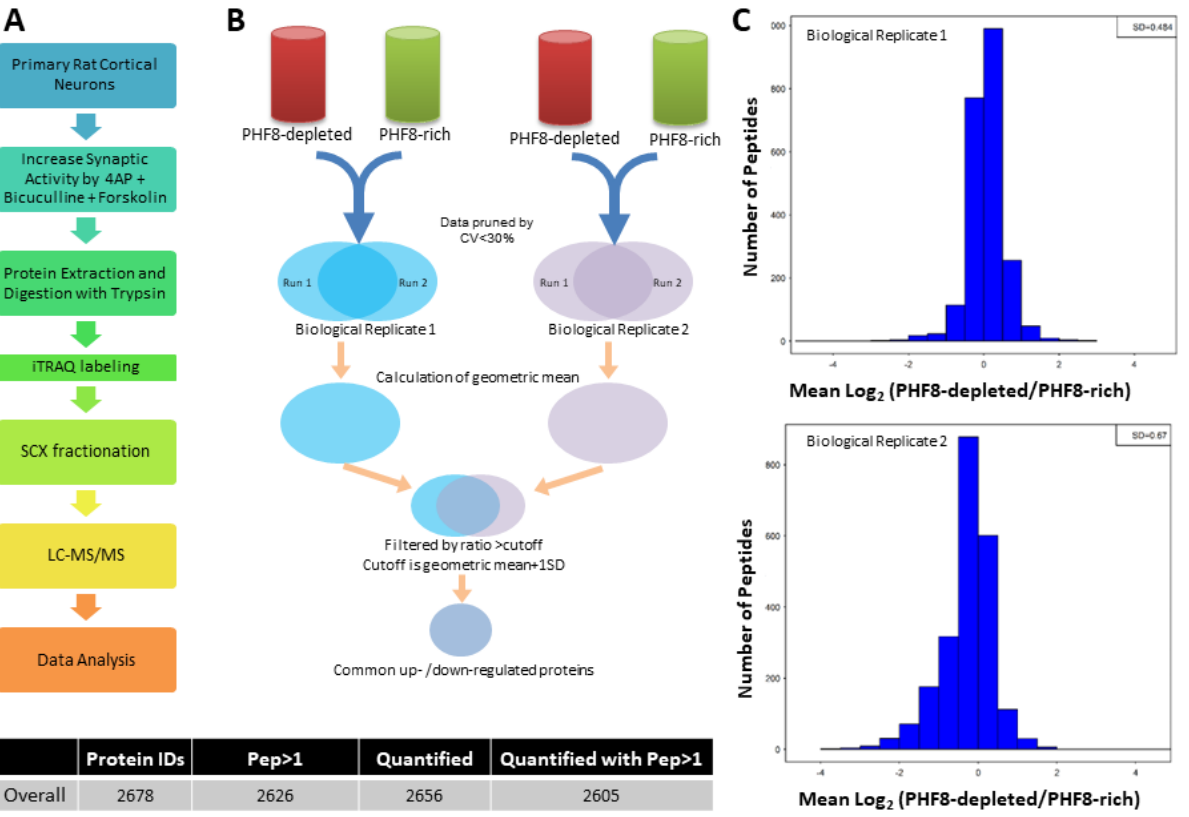
Figure 1. Schematic representation of the proteomic study protocol and the geometric means of biological replicates used in the study. ( A ) Workflow of proteomic experiment. ( B ) Schematic of the iTRAQ quantitative proteomics protocol where two biological replicates are run through the mass spectrometer in duplicate (Run 1 and Run 2), which are then combined. ( C ) Normogram of the number of peptides against the mean log2 frequency distribution.